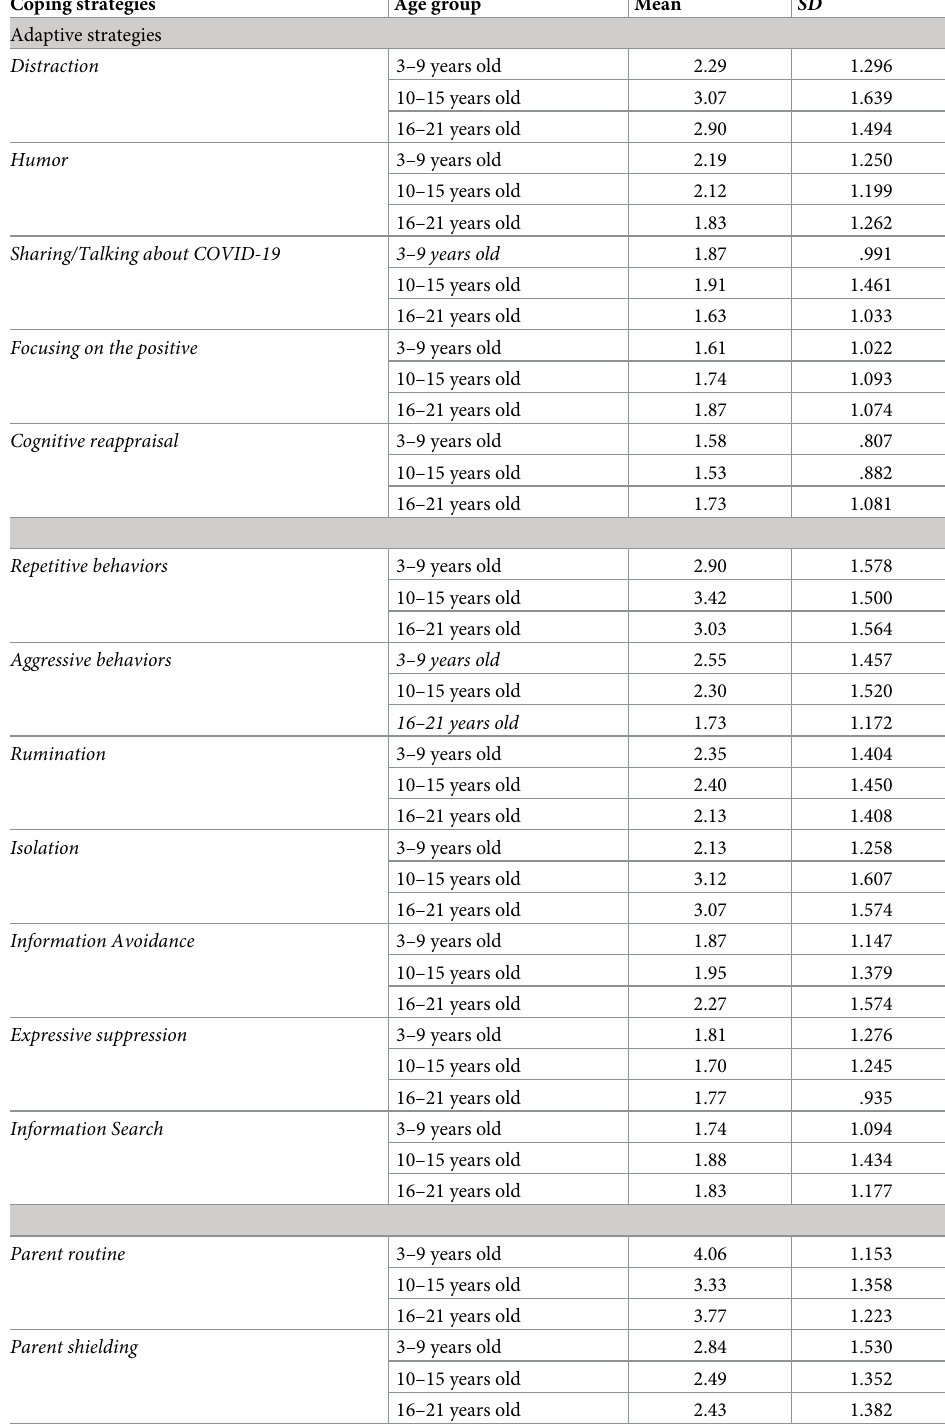
Table 5. Frequency of coping strategies across age